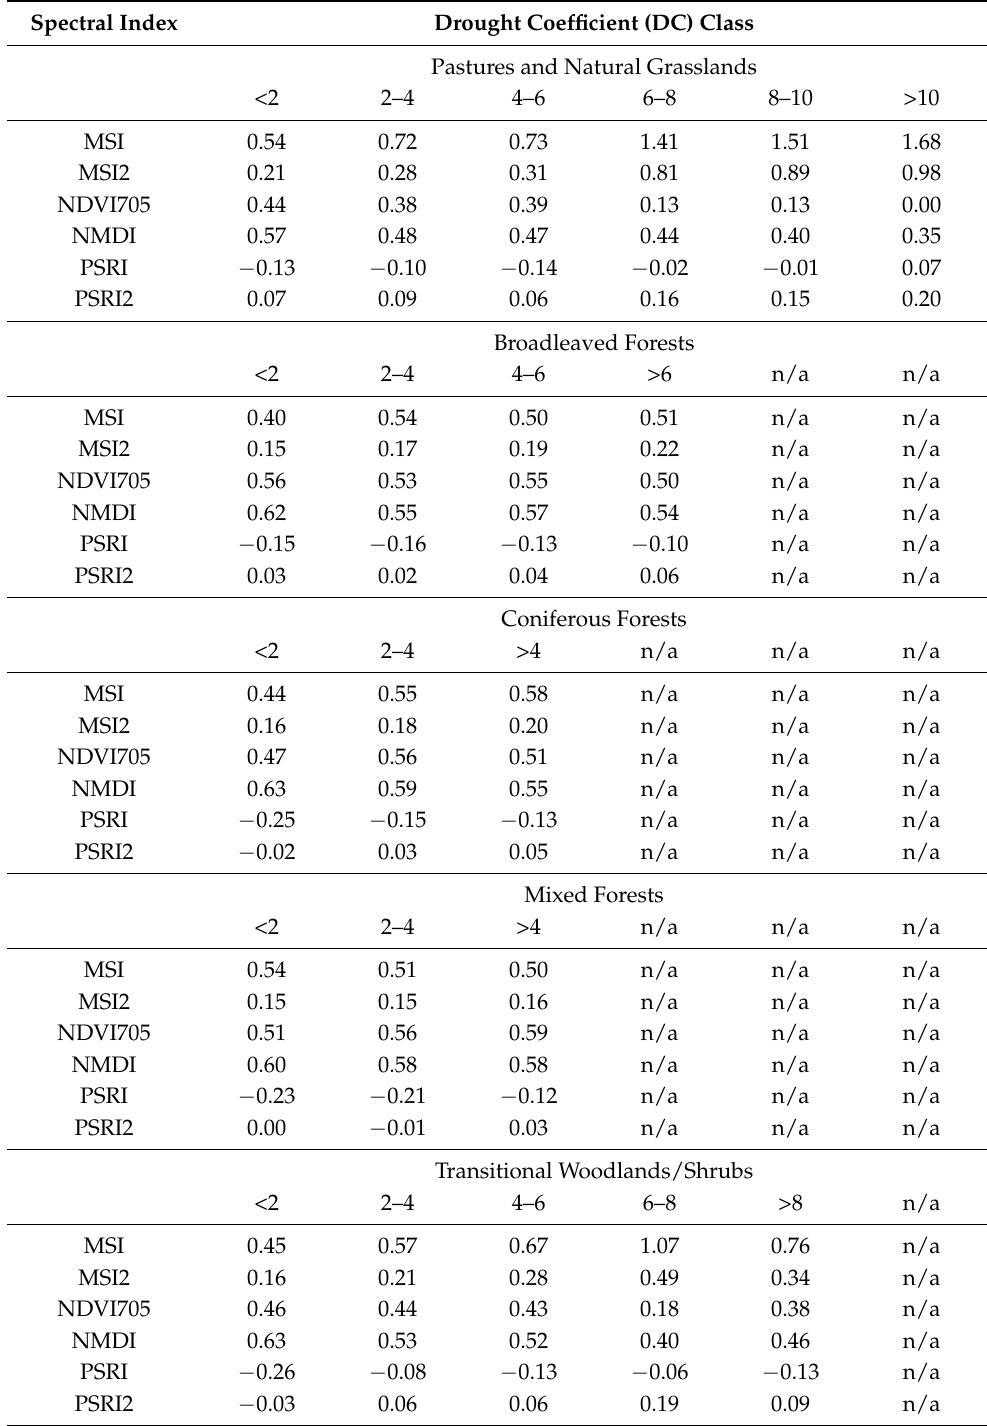
Table 6. Spectral indices values of the individual land cover classes (LCCs) differently affected by drought: pastures and natural grasslands; broadleaved forests; coniferous forests; mixed forests; transitional woodlands/shrubs. The Drought coefficient (DC) classes presents the differently affected by drought point locations (point-based